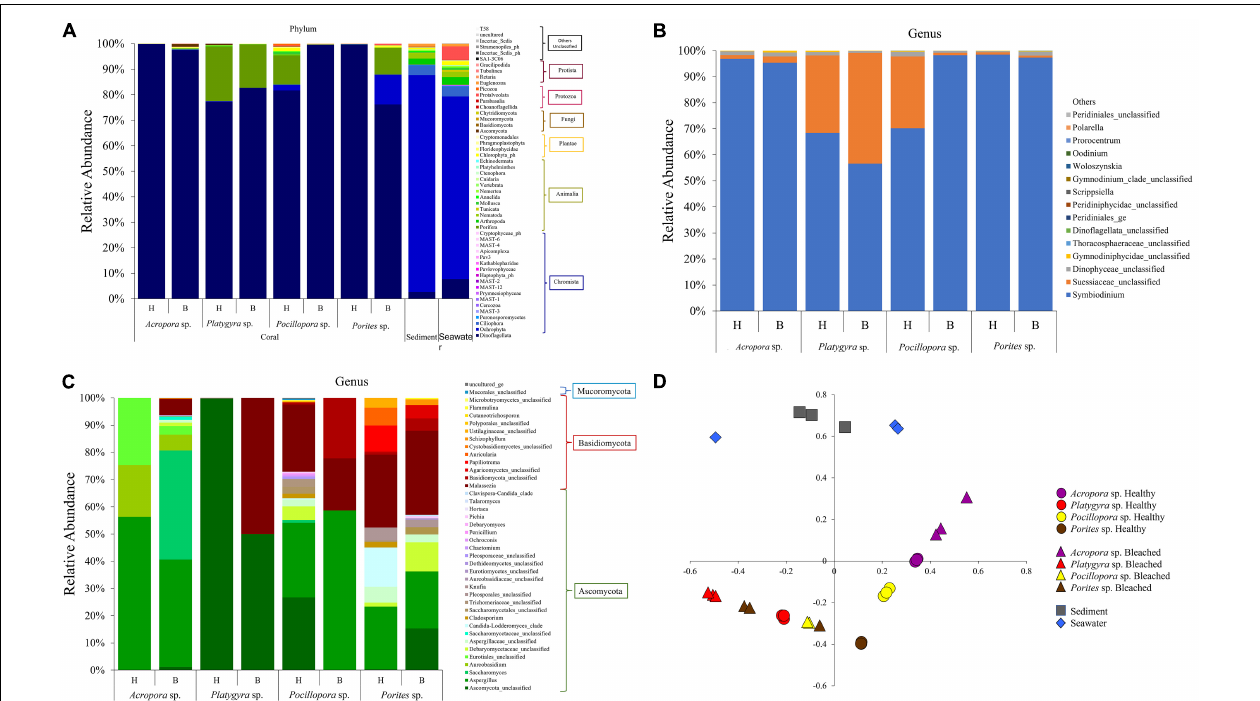
FIGURE 2 | Average microbial eukaryotic compositions in coral, sediment, and seawater samples at (A) phylum level and (B , C) genus level (genus compositions of (B) Dinoflagellata and (C) fungi); and (D) their non-metric multidimensional scaling analyses based on ThetaYC index at the genus level. In panels (B,C) , “Others” represent genus OTUs with < 1% abundance. For OTU classification where genus could not be identified, the deepest classification level was